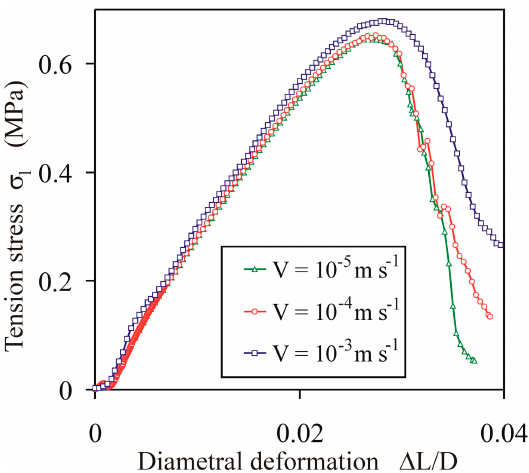
Figure 4. E ff ect of the displacement velocity V on the σ 1 ( ∆ L / D ) characteristic of agglomerates for Figure 4. Effect of the displacement velocity V on the σ 1 ( Δ L / D ) characteristic of agglomerates for σ c = σ c = 10 MPa and E b = 200 10 MPa and E b = 200 MPa.